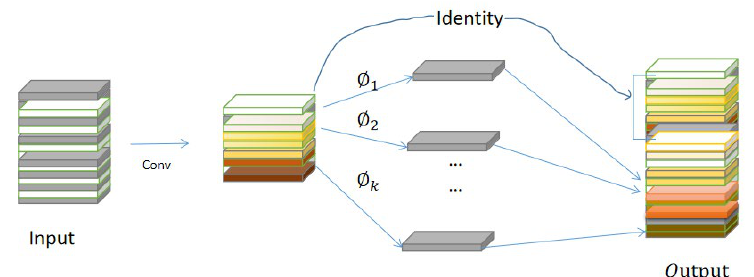
Figure 3. Schematic Diagram of Ghost Convolution